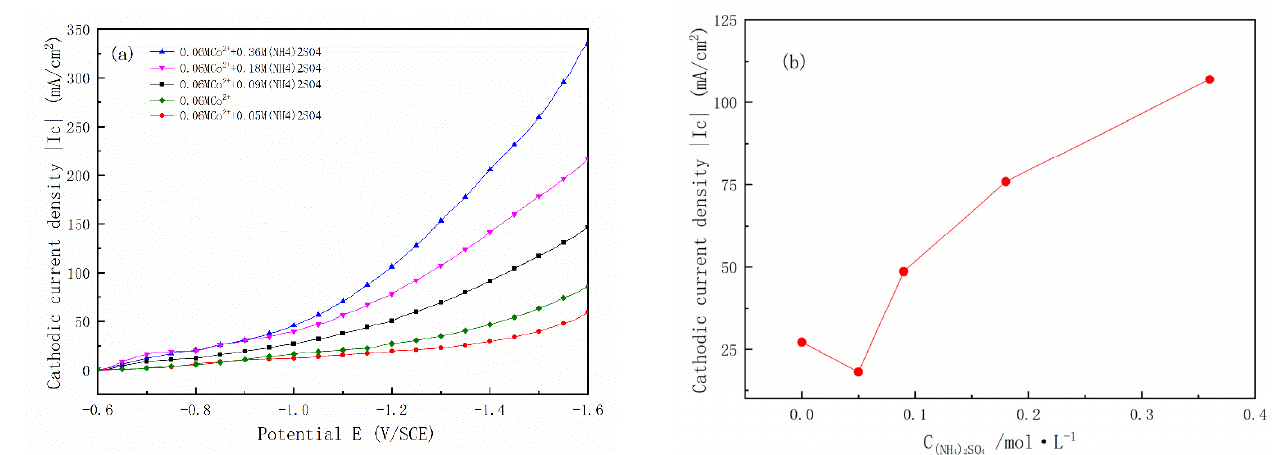
Figure 6. ( a ) Cathodic polarization curves measured in solutions with di ff erent (NH 4 ) 2 SO 4 concen- trations with 0.06 M Co 2+ ; ( b ) the corresponding cathodic current density |Ic| at a potential of − 1.2 V.